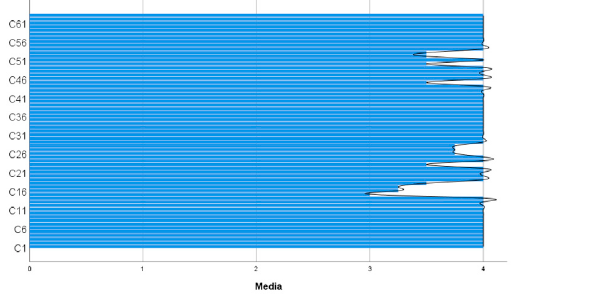
Graph 1. Mean of the Clarity